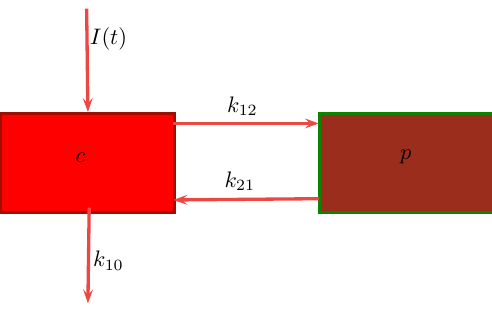
Figure 1. Two-compartment model with intravenous (I.V.) infusion introduced into the plasma